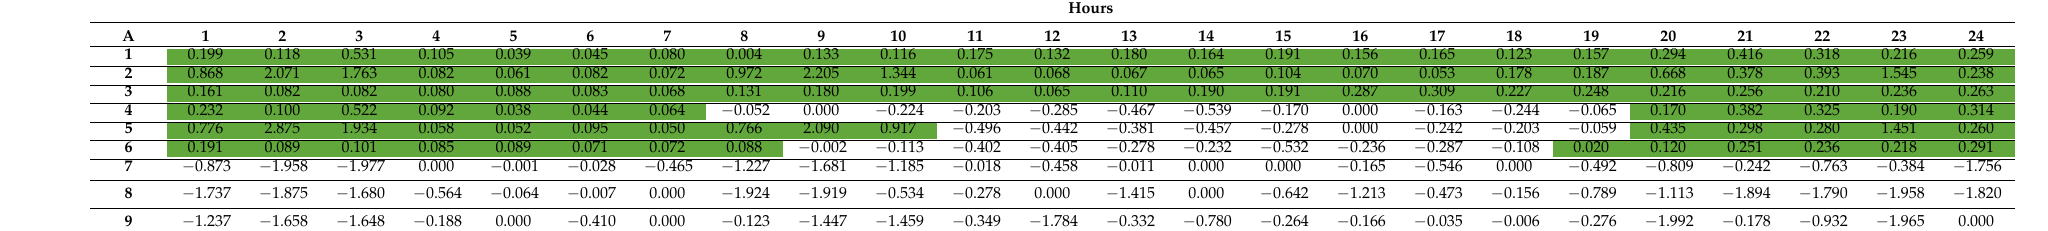
Table 6. Bid or offer quantity by agent.